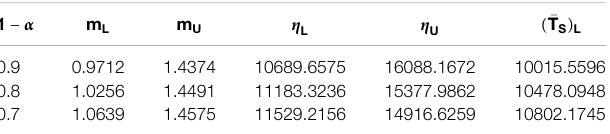
TABLE 7 | The con fi dence interval for the distribution parameter and lower con fi dence limit for the average life of the wind turbine under different con fi dence